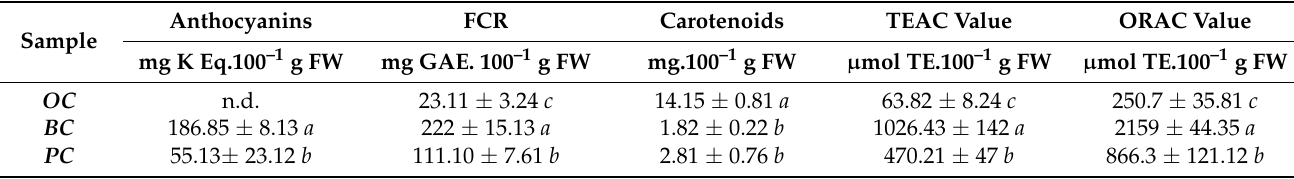
Table 5. Anthocyanins, Folin–Ciocalteu reagent (FCR) reducing capacity, carotenoids and antioxidant capacity values (by TEAC and ORAC assays) in orange carrots (OC), black carrots (BC) and purple “Polignano” carrots (PC), per 100 g fresh weight